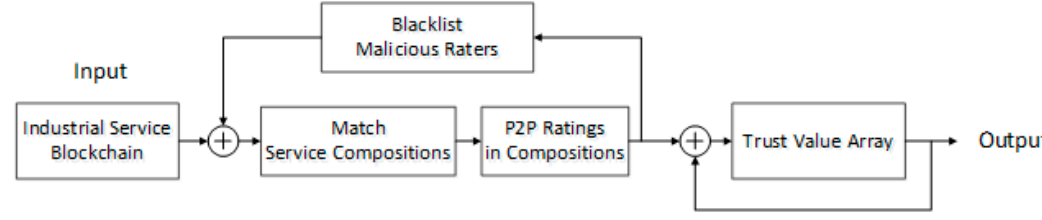
Figure 2. Adaptive trust evaluation model based on the IIoT service compositions.